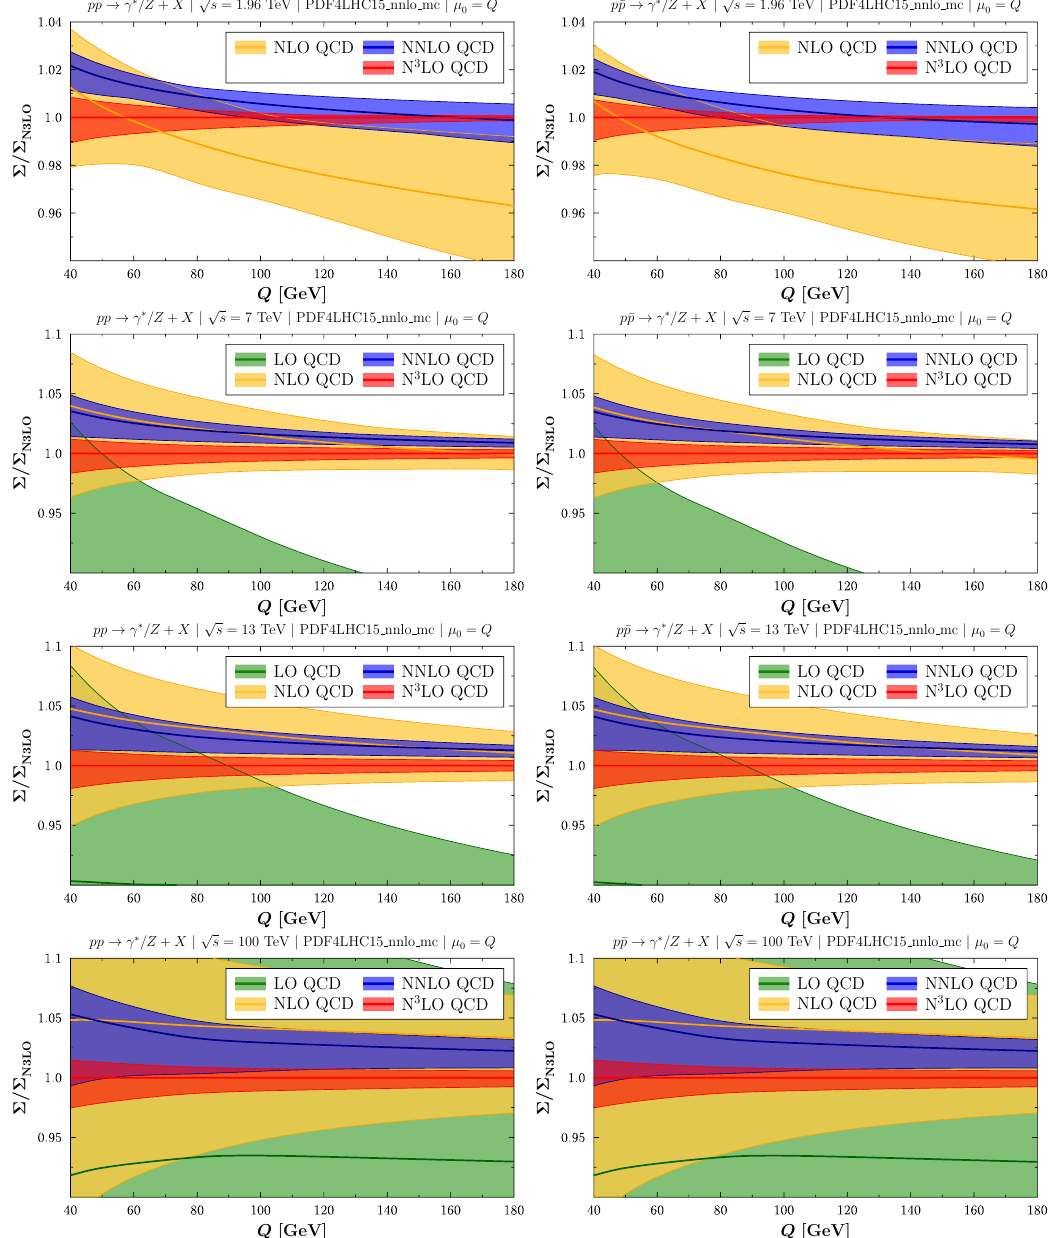
Figure 3 . Dependence of the neutral-current γ/Z Drell-Yan cross sections on the invariant mass Q of the lepton pair in the final state (in GeV) normalized to the N 3 LO cross section at various center of mass energies for the pp (left column) and p ¯ p collisions (right column). The bands indicate the 7-point scale uncertainty at each corresponding perturbative